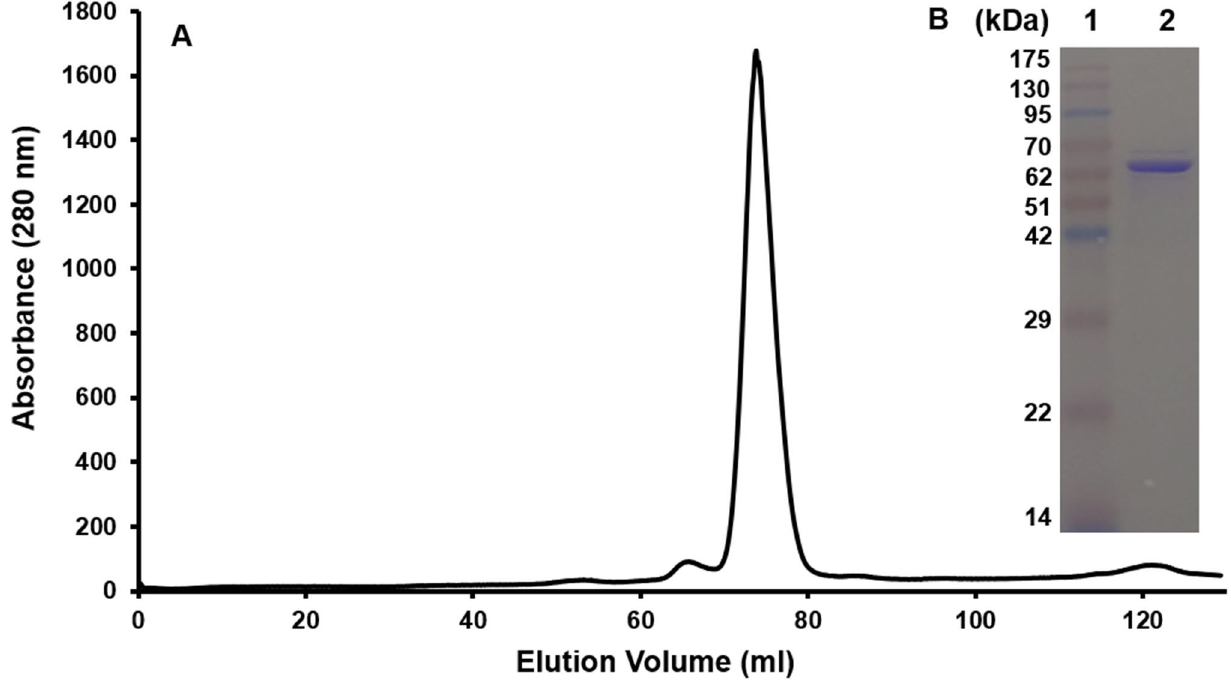
Figure 3. Purification of wt-saPolX and H435A protein. ( A ) The gel filtration chromatogram for wt-saPolX is shown. The gel filtration profile showed the presence of a single peak with V R ~ 74 ml. ( B ) SDS-PAGE analysis of purified wt-saPolX protein showed the presence of a single band corresponding to 66.97 kDa. The H435A and H435A/D193A mutants used in this study were purified with the same protocol as wt-saPolX. The gel filtration chromatogram for mutant proteins also showed the presence of a single peak with V R ~ 74 ml and SDS-PAGE analysis of purified mutants showed the presence of a single band in Fidelity and incorporation of ribonucleotides and oxidized nucleotides. We examined the fidelity of wt-saPolX on four gapped DNA substrates wherein each substrate represents one of the four nucleotides (A, T, G or C) at the templating position. Wildtype-saPolX exhibited high fidelity on all four gapped DNA substrates (Fig. 6A–D). To understand the contribution of the PHP domain towards the replication fidelity, we checked the fidelity of the H435A mutant as well (Fig. 6E–H). We observed that the H435A mutant showed significant misincorporation of dGMP opposite templating nucleotide dT. To analyze the role of PolXc in misincorpo- ration, we checked the catalytic efficiency for the incorporation of dGMP opposite templating nucleotide dC (k cat /K M = 4.10 × 10 –1 μM −1 min −1 ) and opposite templating nucleotide dT (k cat /K M = 2.95 × 10 –4 μM −1 min −1 ) by H435A mutant (Table 1). The misincorporation of dGMP opposite templating nucleotide dT was 1,350-fold lesser than its correct incorporation opposite templating nucleotide dC (Table 1). Members of the X-family are known to incorporate rNTPs and hence the ability of saPolX to discriminate between dNTPs and rNTPs was evaluated. For this, the rNTP incorporation activity of wt-saPolX and H435A in the case of all the four DNA substrates was assayed. We observed that wt-saPolX was not able to incorporate any of the rNTPs (Fig. 7A–D), whereas the exonuclease mutant H435A was able to add rNTPs to various efficiencies (Fig. 7E–H). H435A mutant inserts rAMP opposite template nucleotide dT, rCMP opposite template nucleotide dG and rGMP opposite template nucleotide dC (Table 1). The incorporation of incoming rCMP against tem- plating dG nucleotide (k cat /K M = 1.52 × 10 –4 μM −1 min −1 ) and incoming rGMP against templating dC nucleotide (k cat /K M = 4.74 × 10 –5 μM −1 min −1 ) were quantifiable but that of other ribonucleotides were not (Table 1). Overall, the experiments with wt- and exo- versions of saPolX show that the ability to prevent rNMP incorporation is enhanced by exonuclease activity residing in the PHP domain. Many DNA polymerases misincorporate oxidized nucleotides such as 8oxodGTP opposite incorrect tem- plating nucleotide. We examined the ability of wt-saPolX and H435A to incorporate oxidized nucleotides on all the four gapped DNA substrates in the presence of Mg 2+ . wt-saPolX was unable to incorporate 8oxodGMP opposite any of the templating nucleotides (Fig. 8A). However, the saPolX- H435A was able to insert 8oxodGMP against templating nucleotide dA and dC both with a clear preference for templating nucleotide dA (Fig. 8B). The steady-state kinetics data supported this observation where we could find the catalytic efficiency for the incorporation of 8oxodGMP opposite templating nucleotide dA (k cat /K M = 1.83 × 10 –4 μM −1 min −1 ) by H435A mutant (Table 1). wt-saPolX was able to insert 2-OH-dAMP against templating nucleotide dT in gapped DNA substrate to a significant degree (Fig. 8C), whereas H435A was able to misincorporate 2-OH-dAMP against templating nucleotides dG and dC as well (Fig. 8D) (Table 1).